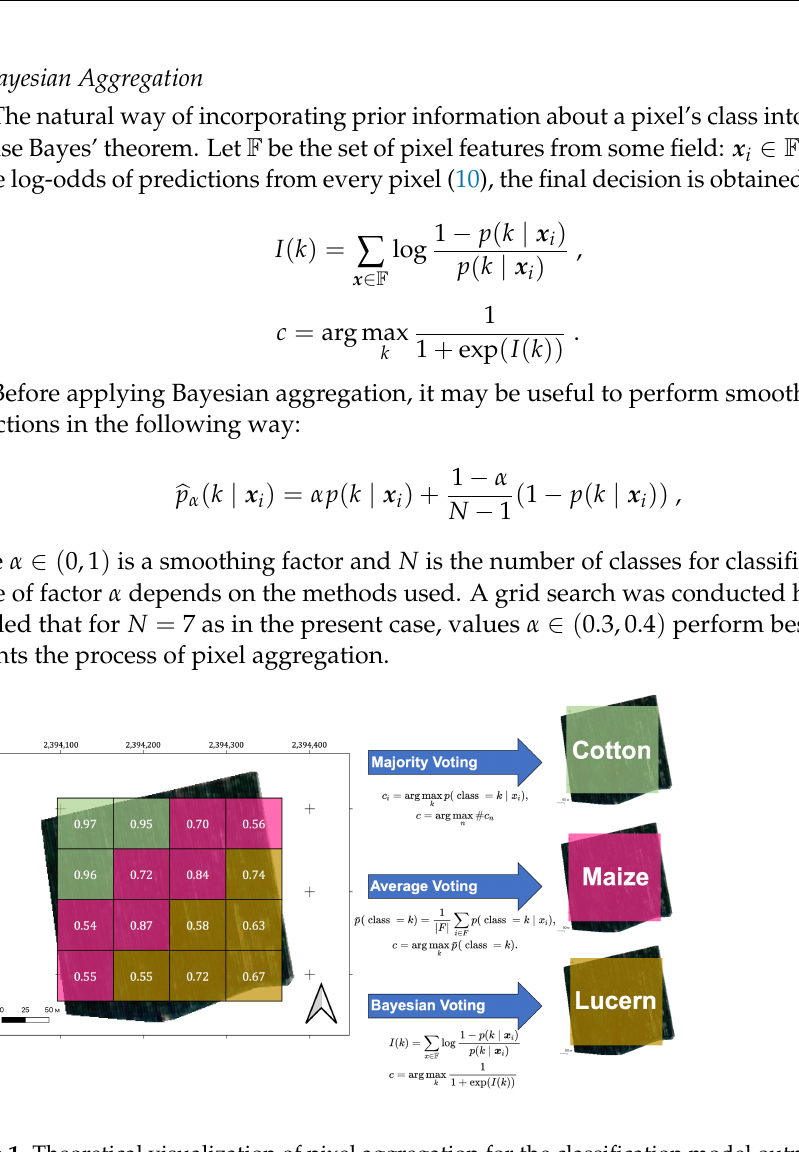
Figure 1. Theoretical visualization of pixel aggregation for the classification model output. Average voting, majority voting and Bayesian voting produce different classes for fields with some pixels assigned to the wrong